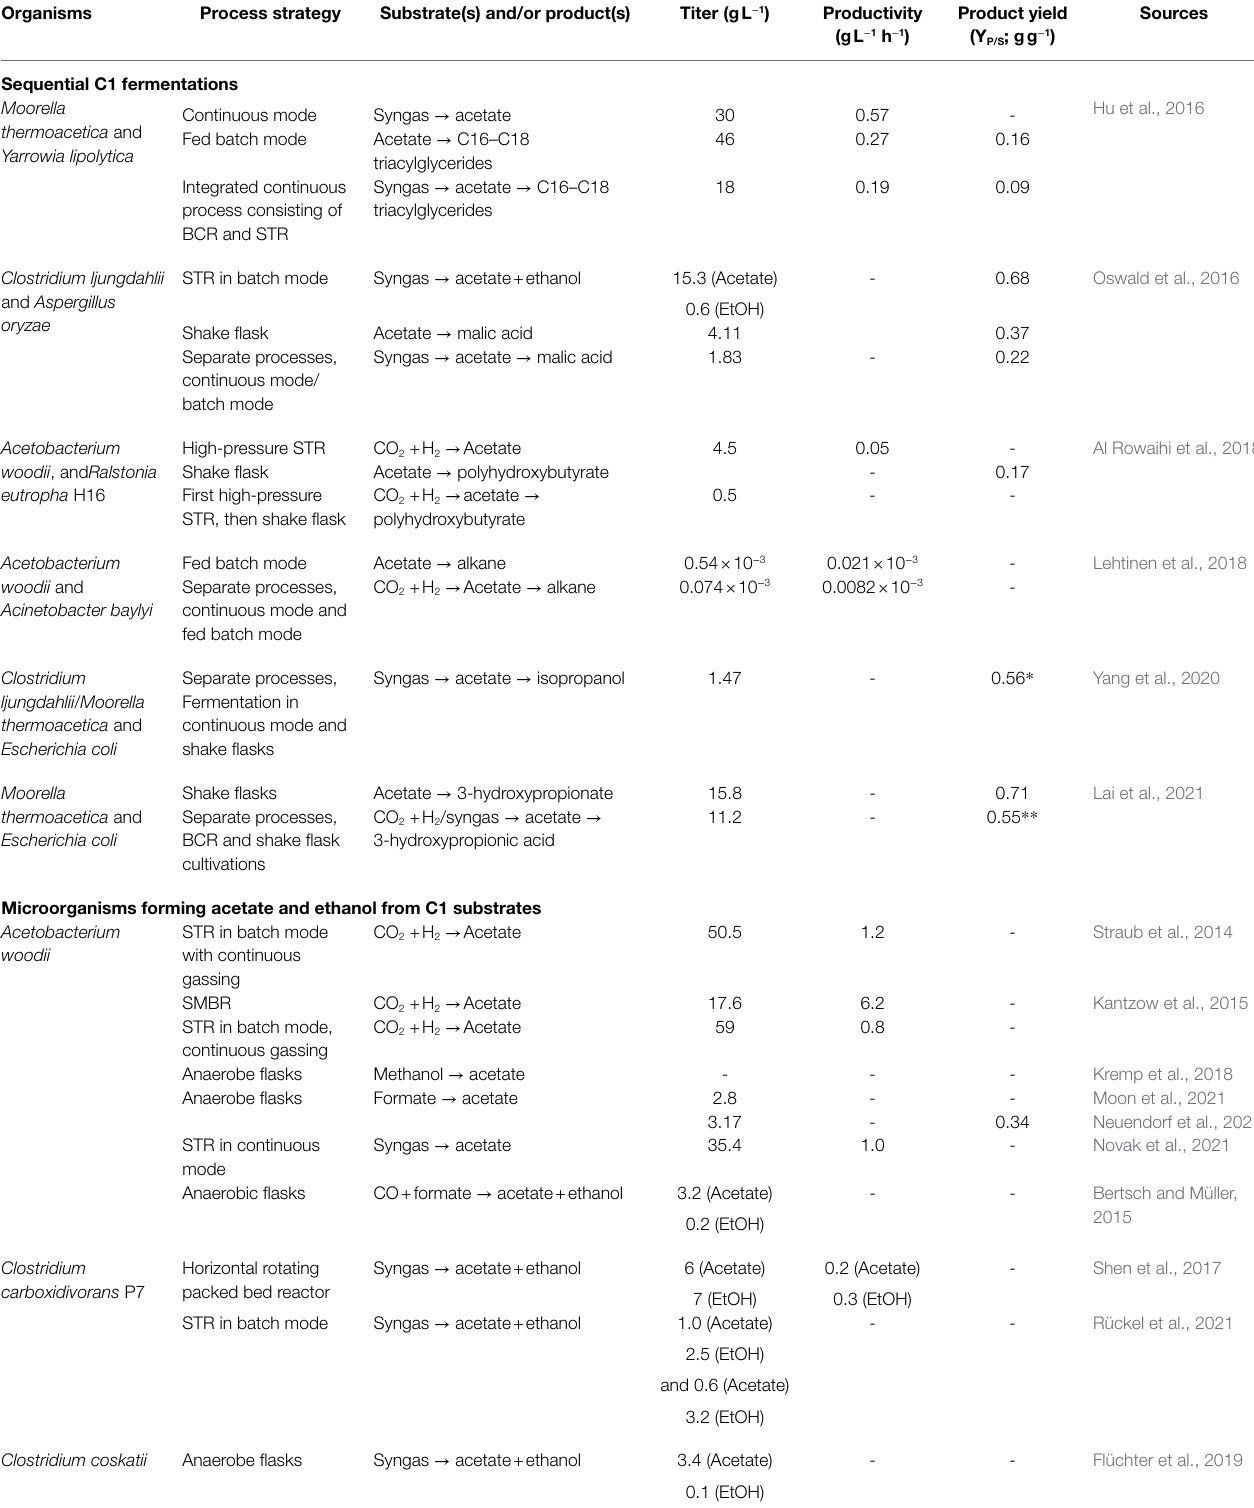
TABLE 1 | The first part gives an overview of the so far published approaches for sequential C1 fermentations, the second part lists acetogenic bacteria able to generate acetate and/or ethanol from C1